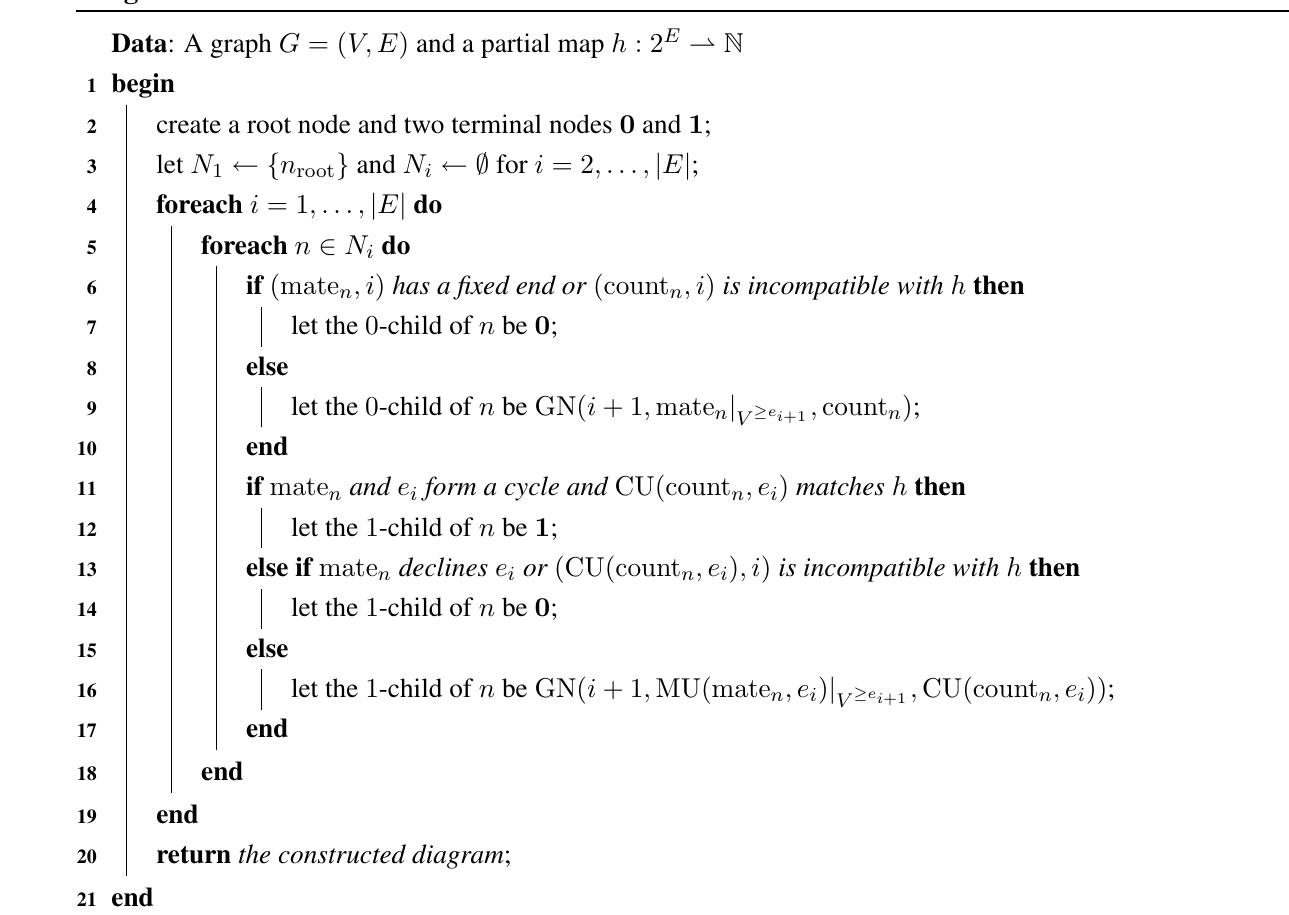
Algorithm 5: Slitherlink